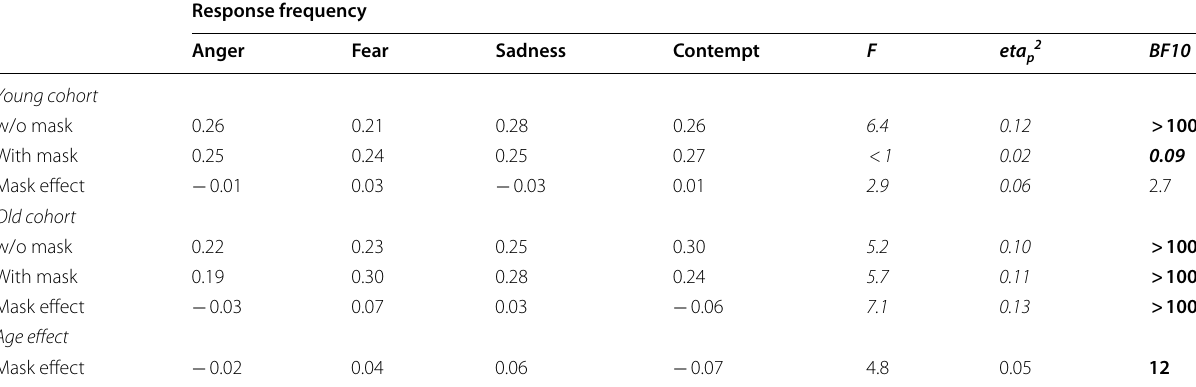
Positive signs indicate higher response frequencies for masked facial expressions / larger mask effects in the old cohort. BF10 > 3.0 (at least moderate evidence for an effect) are bold and BF10 < 0.30 (at least moderate evidence for no effect) are bold and in